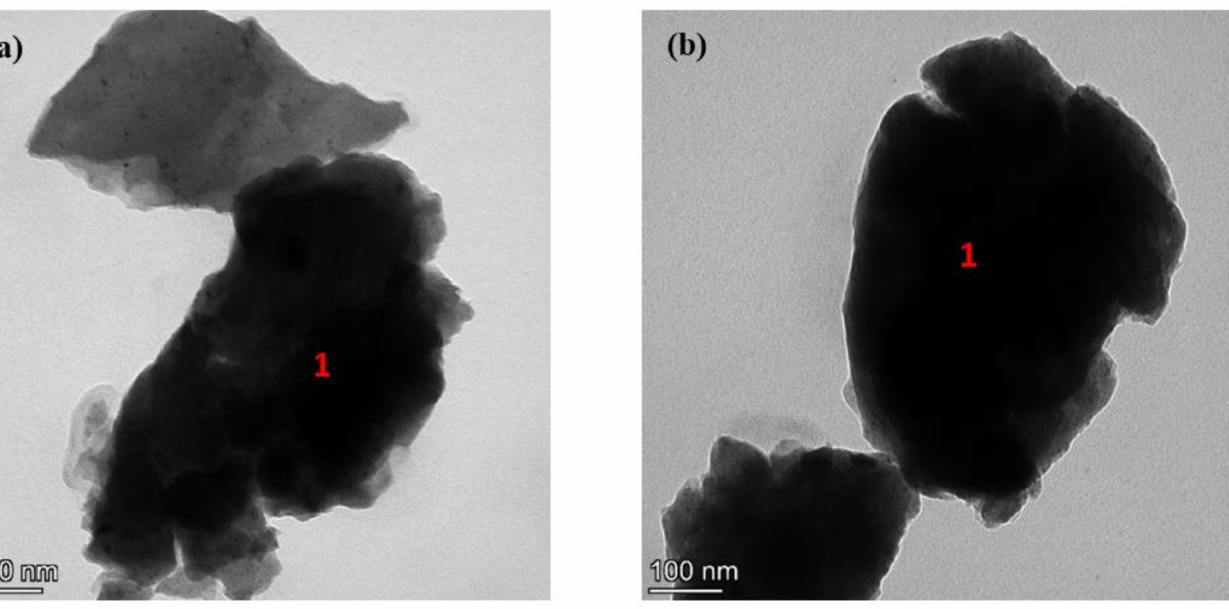
Figure 13. TEM images of a cluster of particles containing Graphite (1), SiC (2), and detached pin constituents with attached friction layer (3). Inset scale: 5 nm − 1 .